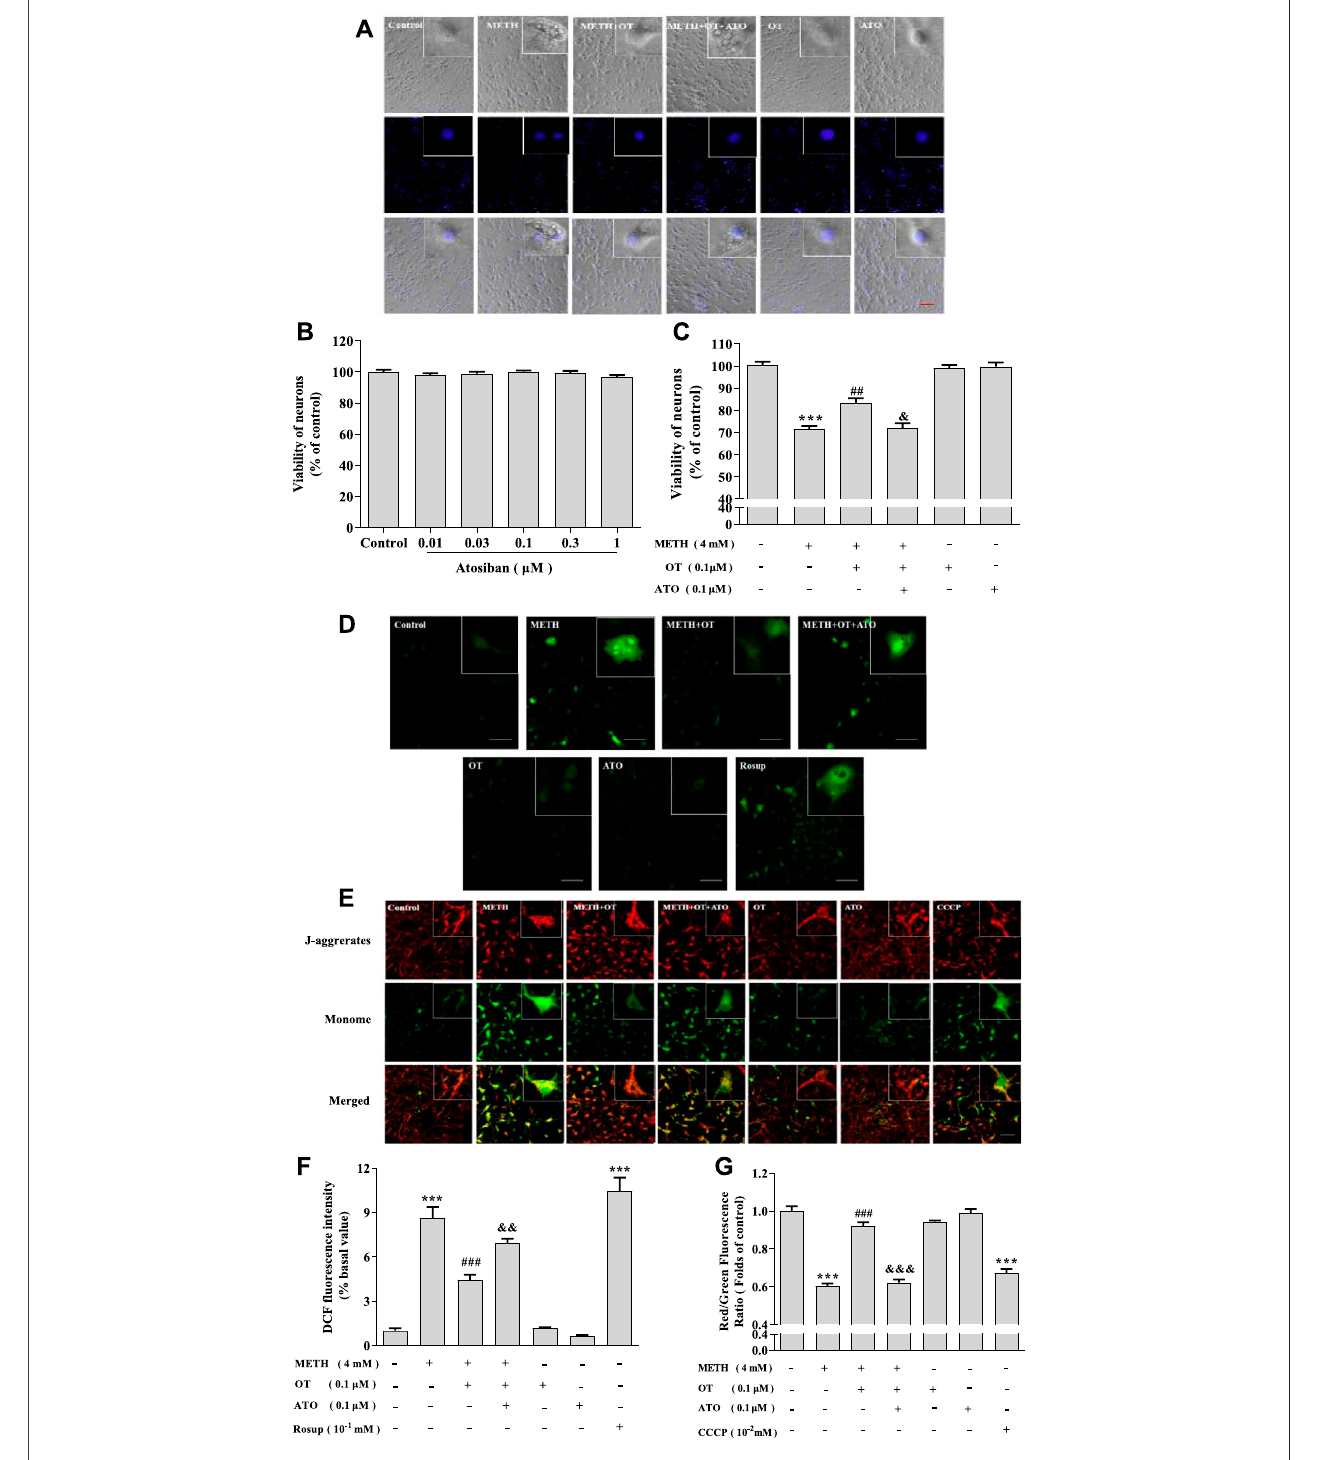
FIGURE 2 | Oxytocin receptor participated in the prevention of METH -induced cytotoxicity in hippocampal neurons. (A) Hippocampal were pre-treated with OT and ATO for 2 h and stimulated with METH for 24 h. The cells were observed under a fl uorescence microscope. ( × 20 objective; Scale bar (cid:2) 50 μ m). (B) Hippocampal neurons were treated with ATO (0.01 – 1 μ M) for 24 h. (C) Hippocampal neurons were pre-treated with OT (0.1 μ M) and ATO (0.1 μ M) for 2 h and stimulated with METH (4 mM) for 24 h before detected. (D,F) Cells were observed by confocal microscope after stained with the Fluorescent dye DCFH-DA, DCF (Green fl uorescence)